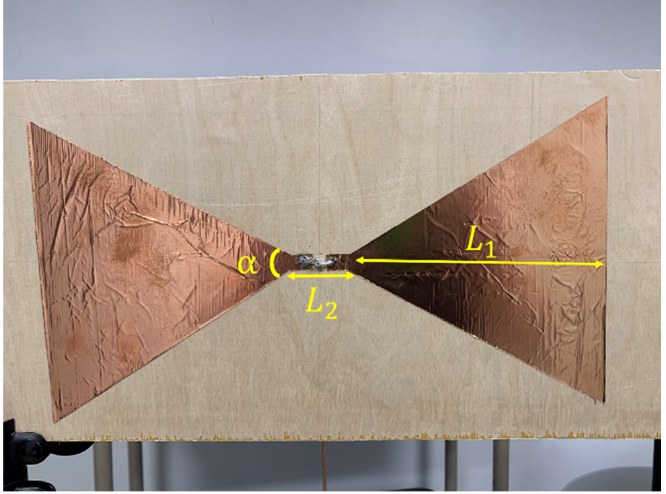
Figure 6. Bow-tie antenna designed around center frequency of 250 MHz, α = 60 degrees, L 1 = 185 mm, and L 2 = 20